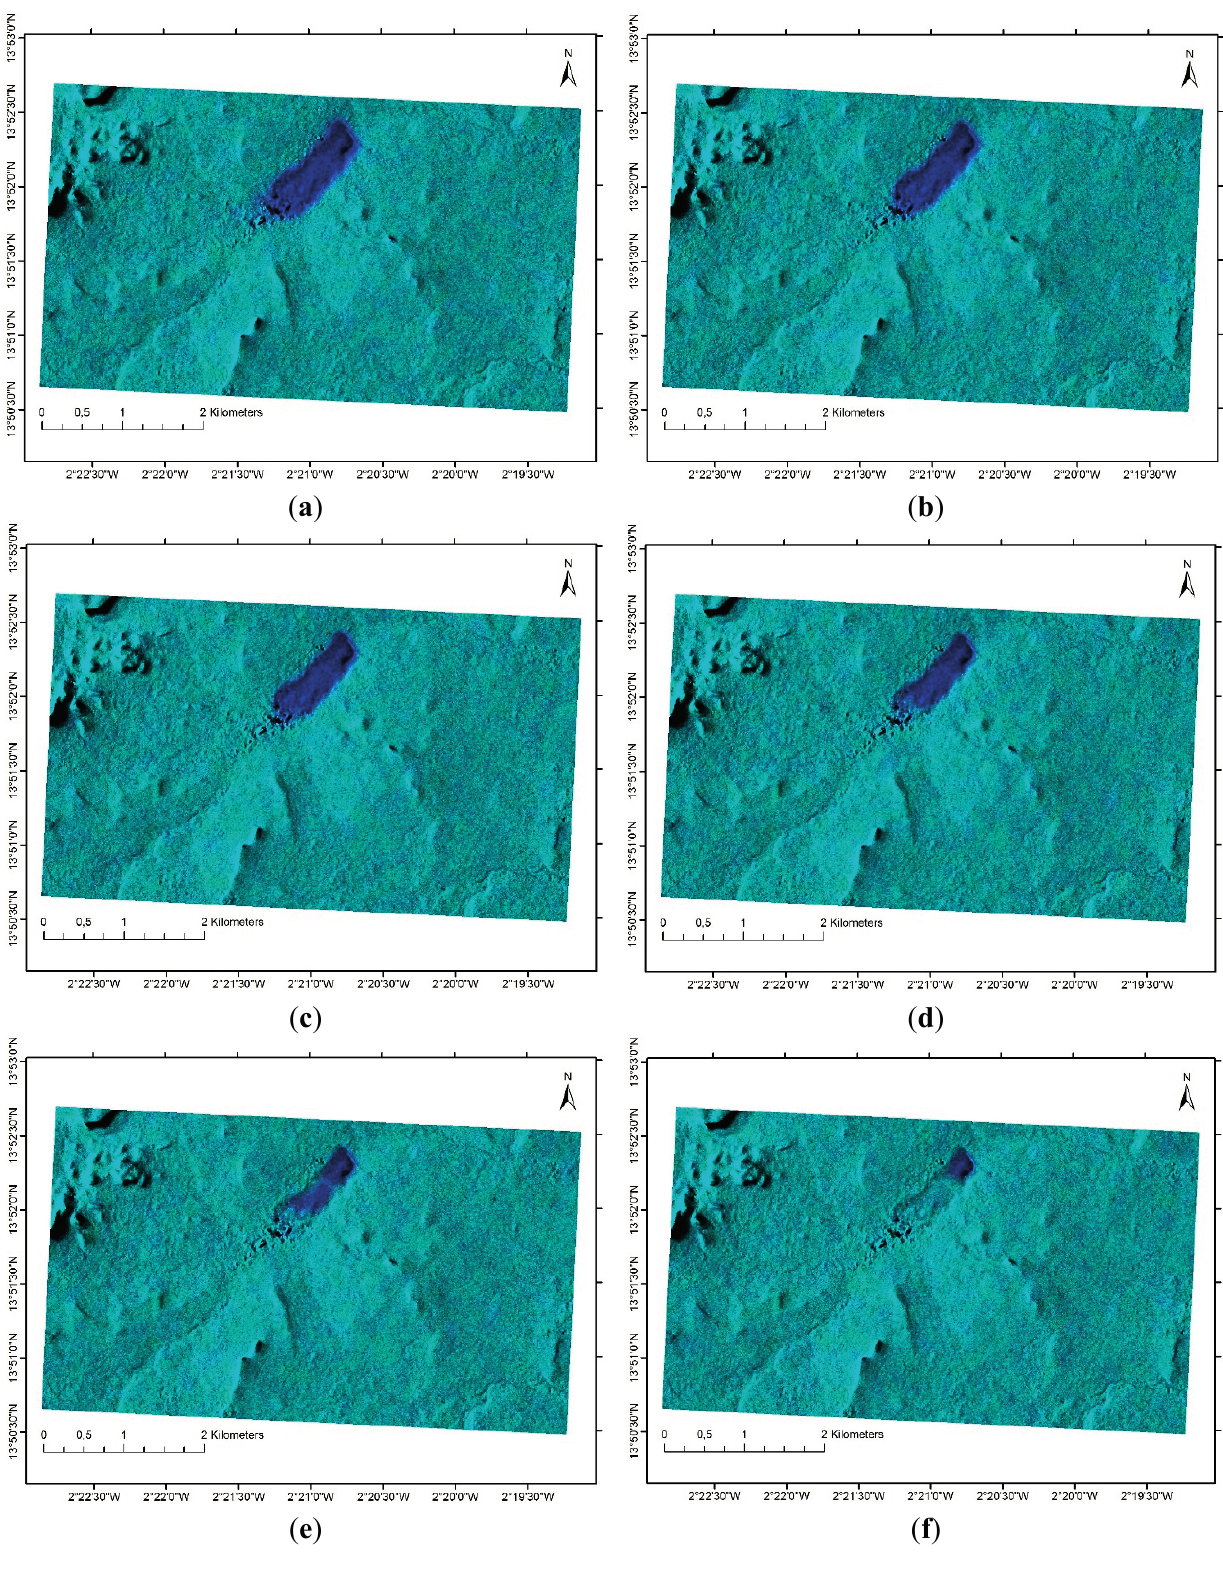
Figure 5. Laaba basin, simulated Sentinel-1 Level 1 α products. Water contour height: ( a ) 341 m, ( b ) 340.5 m, ( c ) 340 m, ( d ) 339.5 m, ( e ) 339 m and ( f ) 338.5 m. The spatial resolution is 5 × 5